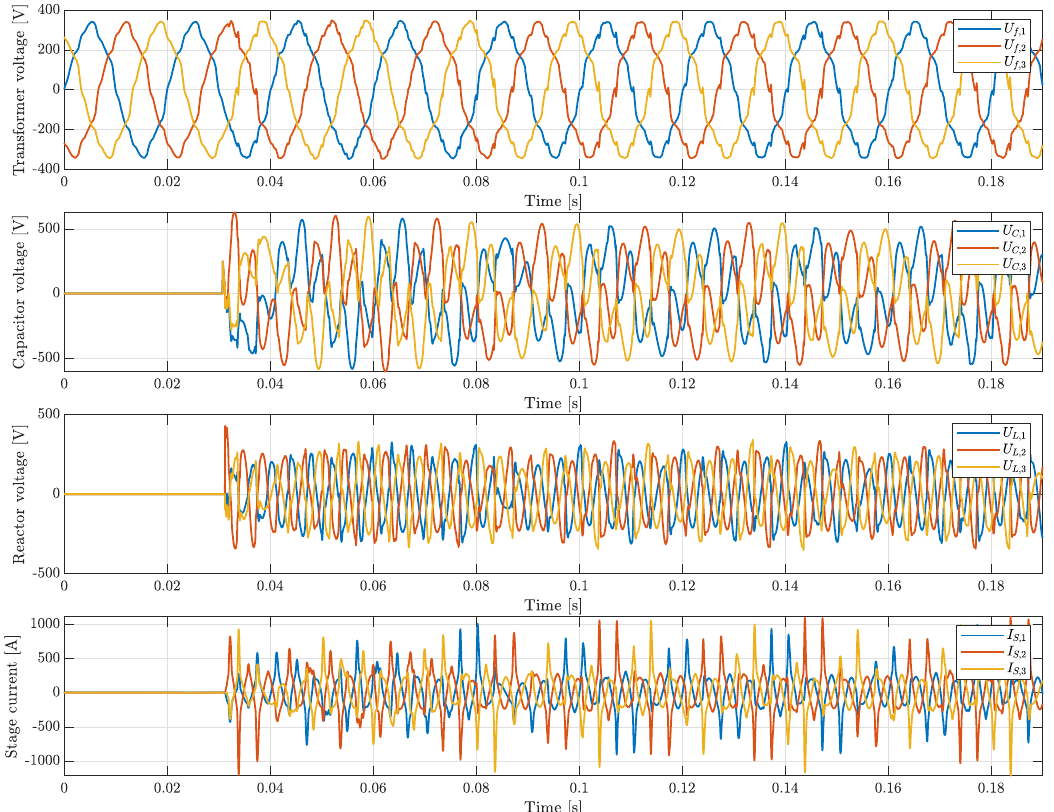
Figure 16. C2—Transformer secondary voltage, capacitor voltage, reactor voltage and capacitor stage current when the stage is switched